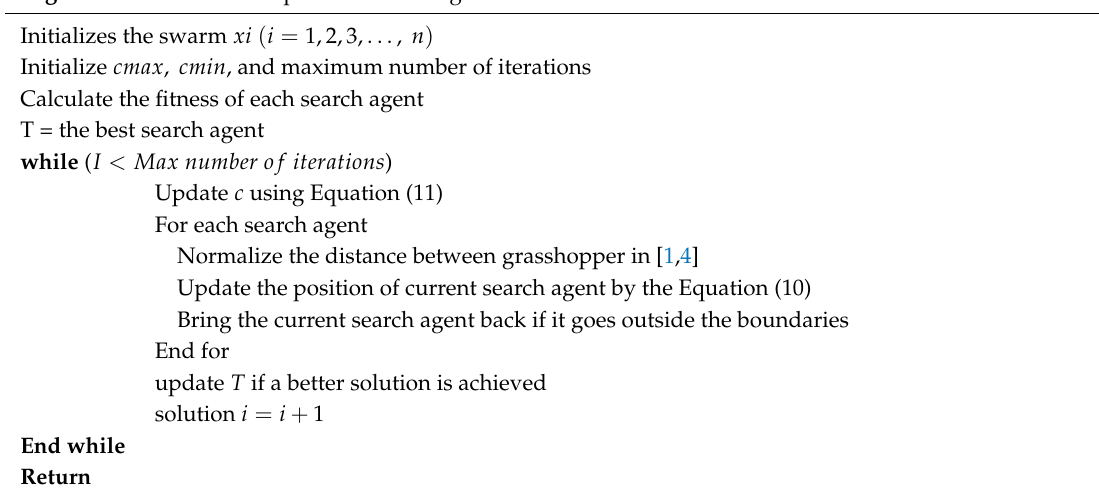
Algorithm 1. The main steps of the GOA